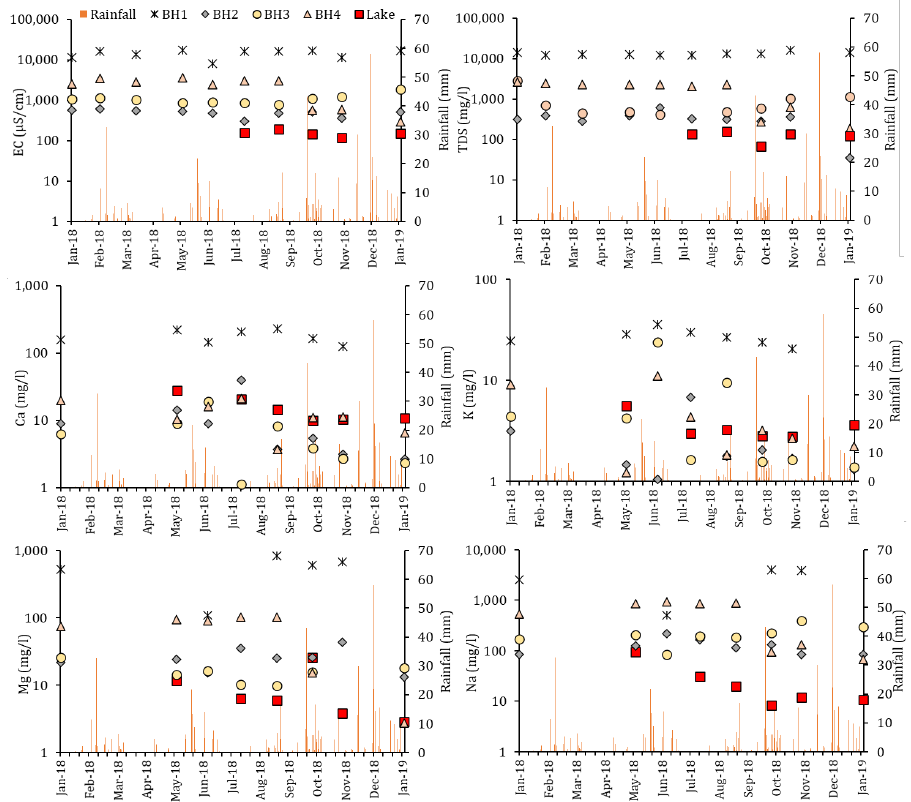
Figure 8. Temporal variation of the physico-chemical parameters and rainfall in the groundwater and the lake water collected from the study area.